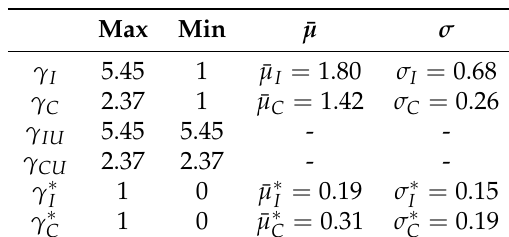
Table 2. Results of isotropy indices.